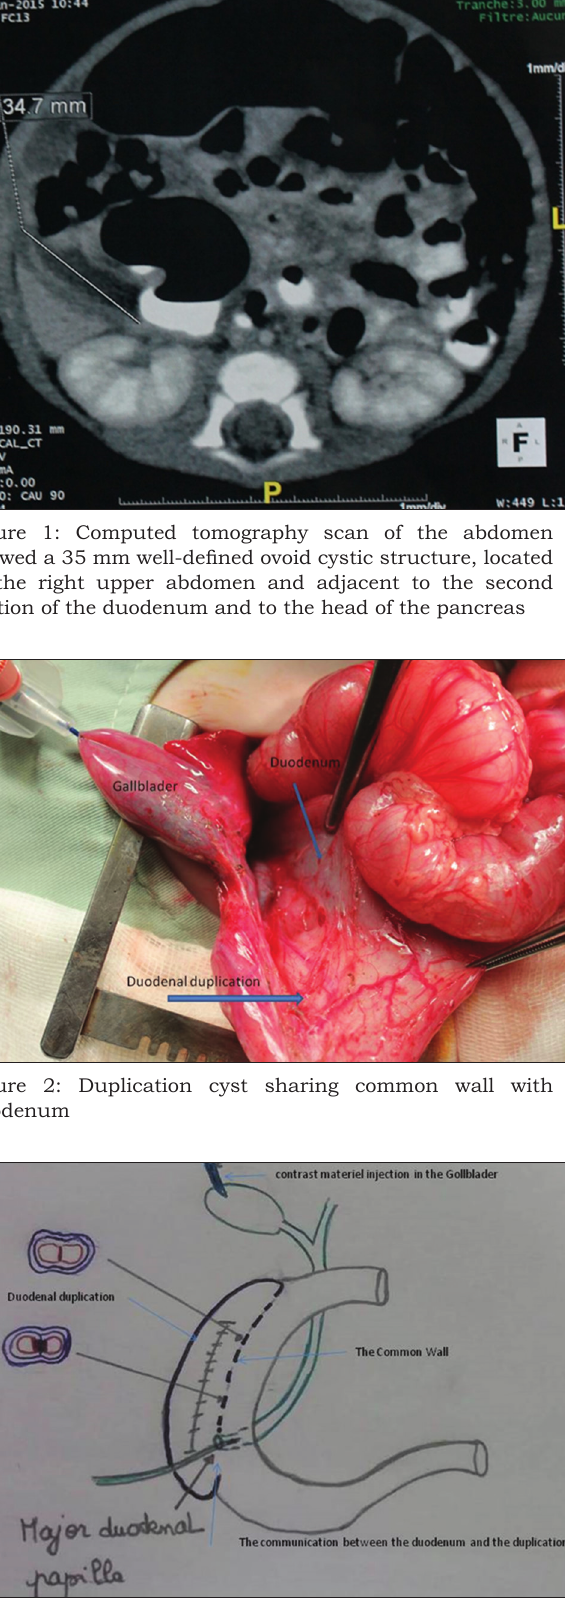
Figure 3: Schematic representation of operative